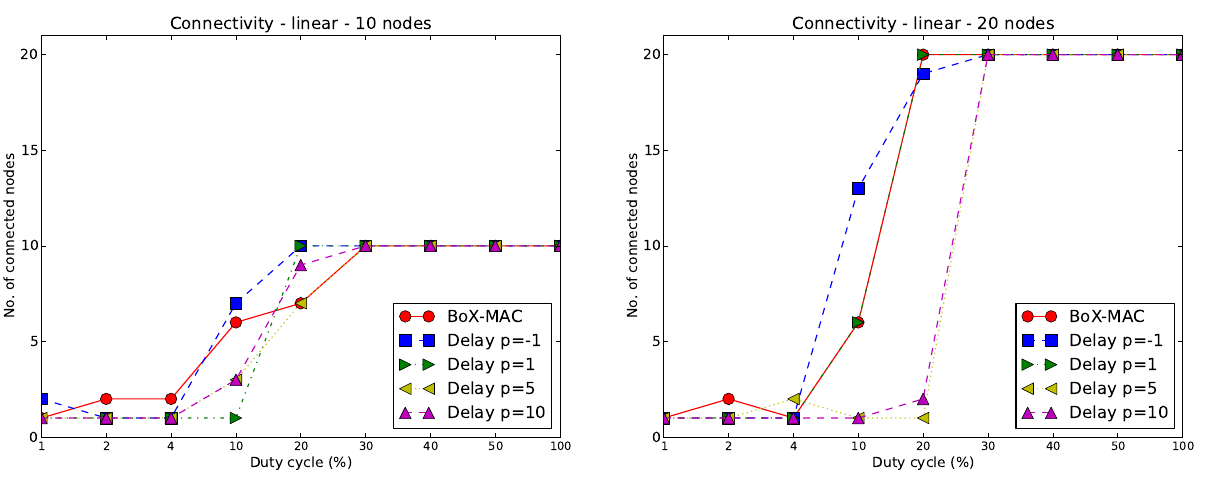
Figure 7. Connectivity of BoX-MAC and CLAC in a 10-node (left) and in a 20-node (right) linear